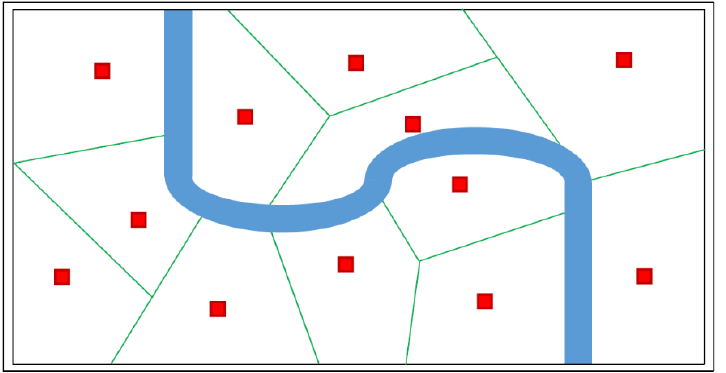
Figure 1. Example of several PS service areas. Red squares are PS service areas, while green lines are the service area boundaries.